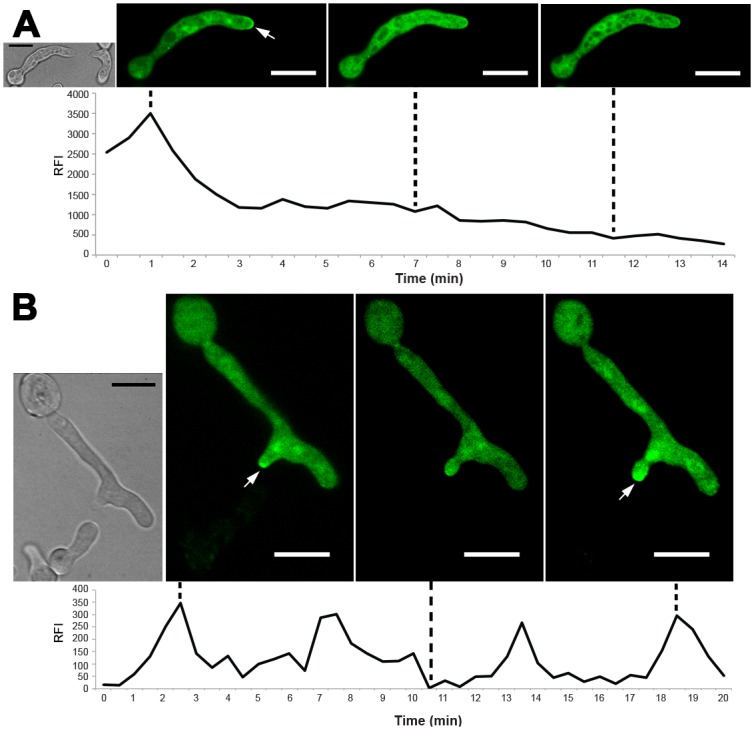
Enforcement of oscillation of signaling proteins is necessary to establish chemotropic interactions regardless of CG.(A) MAK-2-GFP localized to the tips of conidial anastomosis tubes in a Δdoc-1 Δdoc-2 (CG5) germling when in proximity to a CG2 (JW262) germling (top panel). However, further oscillation of MAK-2-GFP did not occur, and chemotropic interactions between the Δdoc-1 Δdoc-2 (CG5) germling and JW262 (CG2) germling were not established. Bottom panel: Graphic representation of MAK-2-GFP signals at the tip of a Δdoc-1 Δdoc-2 (CG5) germling in proximity to a JW262 (CG2) germling. y-axis shows the ratio of relative fluorescence intensity (RFI) in the interacting zone as compared to background. X-axis shows time (min). (B) MAK-2-GFP in a Δdoc-1 Δdoc-2 germling shows continued oscillation to the CAT tip if chemotropic interactions are established between Δdoc-1 Δdoc-2 (CG5) and JW262 (CG2) germlings (top panel). Bottom panel: Graphic representation of MAK-2-GFP signal at the CAT tip of Δdoc-1 Δdoc-2 (CH5) germlings undergoing chemotropic interactions with germlings of JW262 (CG2). y-axis shows the ratio of RFI in the interacting zone as compared to background. x-axis shows time (min) (See S5 Movie for second example).